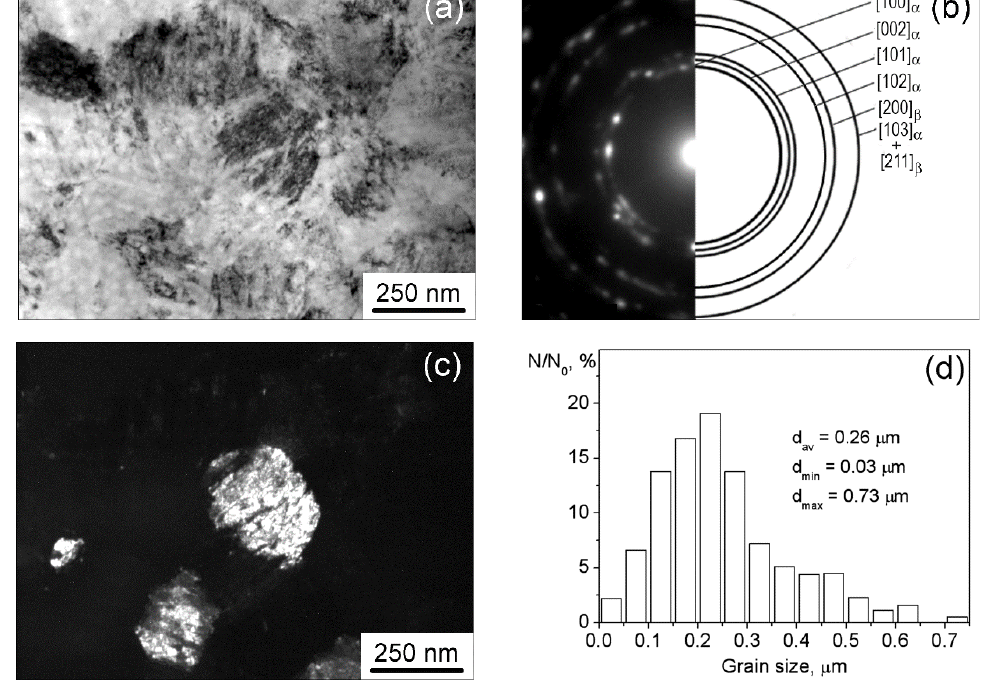
Figure 3. TEM images of the UFG Ti-2.9Al-4.5V-4.8Mo-0.15H alloy: ( a ) bright-field image and ( b ) corresponding SAED; ( c ) dark-field image in the reflection of (002) α type; ( d ) size distribution of grain–subgrain elements.